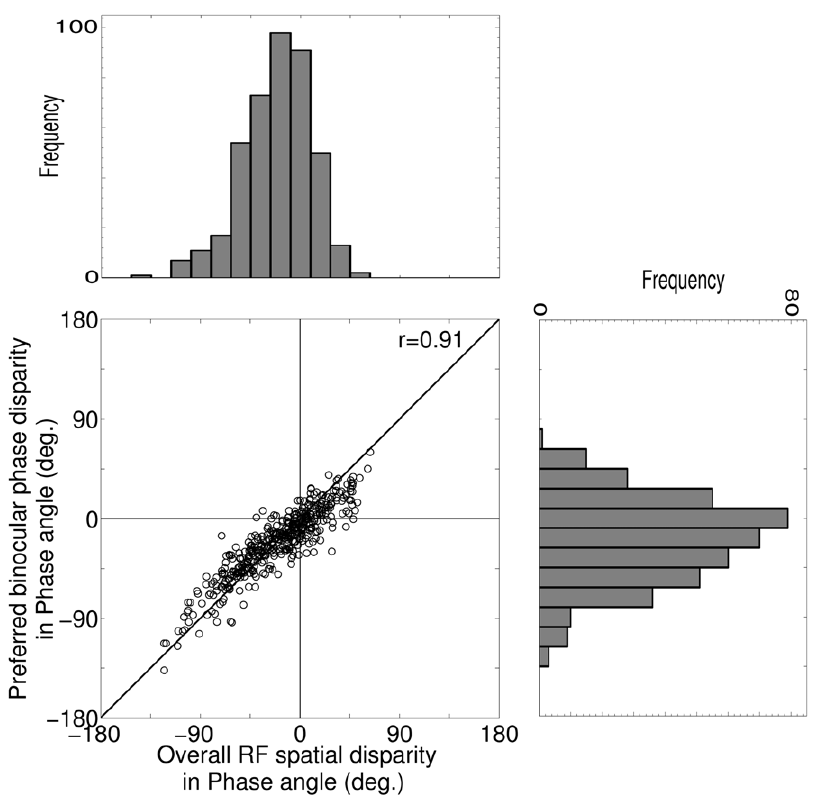
Figure 6. DP versus Overall RF spatial disparity for 415 cells. Scatter plot of preferred binocular phase disparity versus overall RF spatial disparity and their respective histograms. The preferred binocular phase disparity and overall RF spatial disparity shows strong correlation of r=0.91.